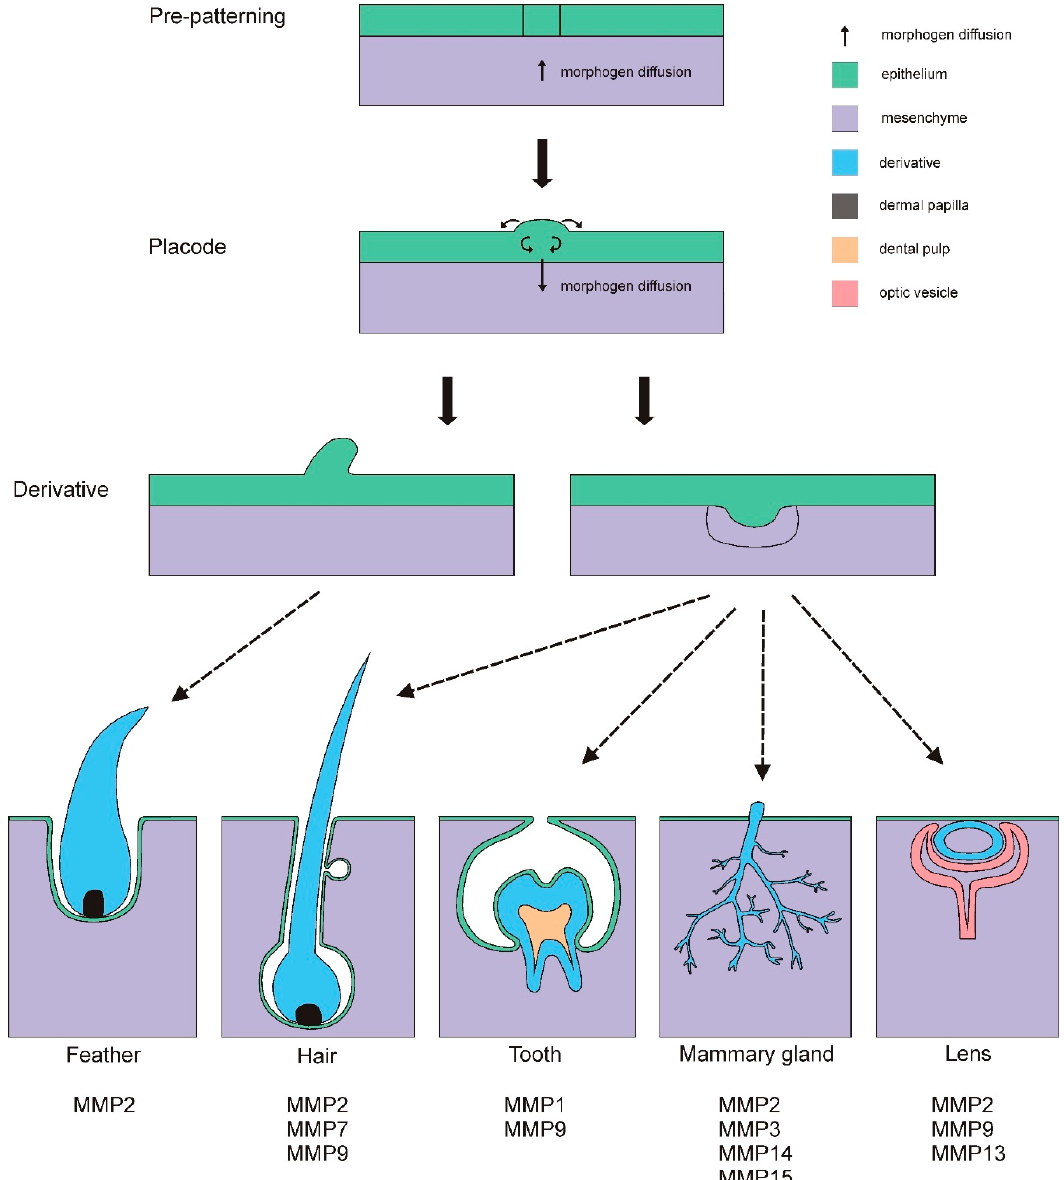
Figure 2. Placode-derived structures begin development with pre-patterning of the epithelium, which involves morphogen diffusion from the mesenchyme to the epithelium. Next, a thickening of the epithelium forms a placode structure. Following the formation of a placode, morphogen signaling from the epithelium down to the mesenchyme leads to the formation of a derivative structure. Some MMPs are involved in some of these processes (see text for details).